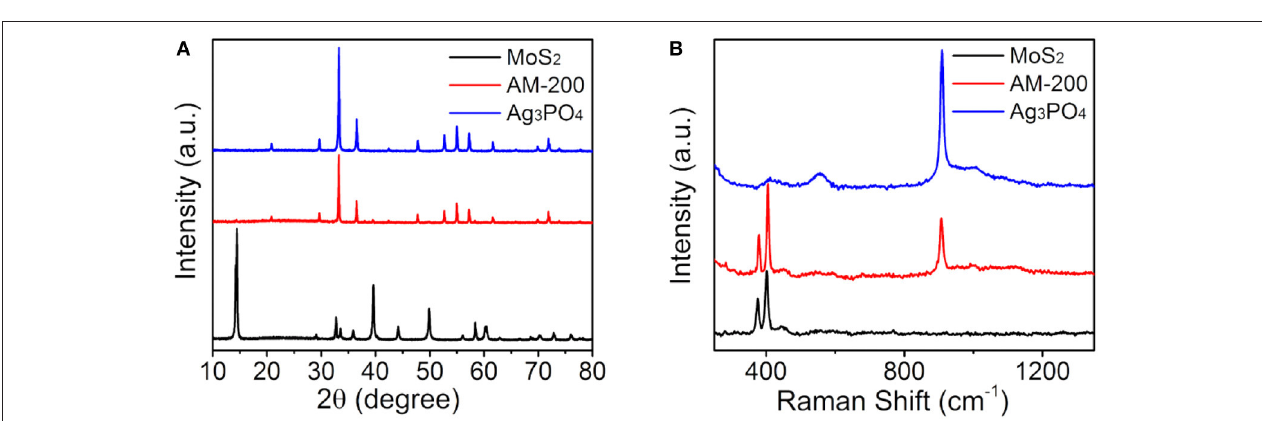
FIGURE 1 | Oxygen-evolving concentrations (A) and rates (B) over different photocatalysts under LED illumination.